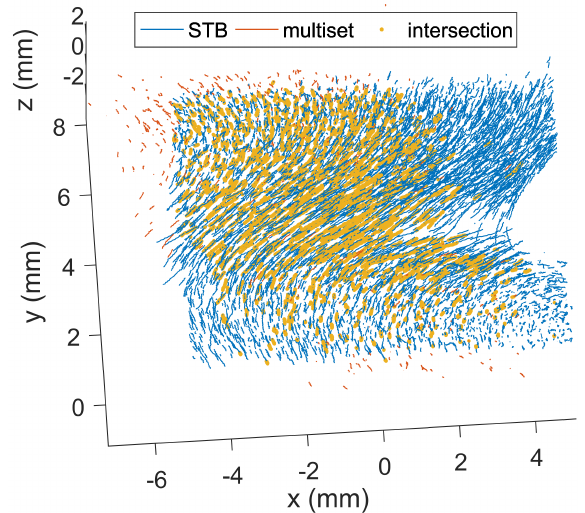
Figure 9. Trajectories obtained from STB (blue) and multiset (red) reconstruction algorithms. The particle positions reconstructed by both algorithms are emphasized by yellow